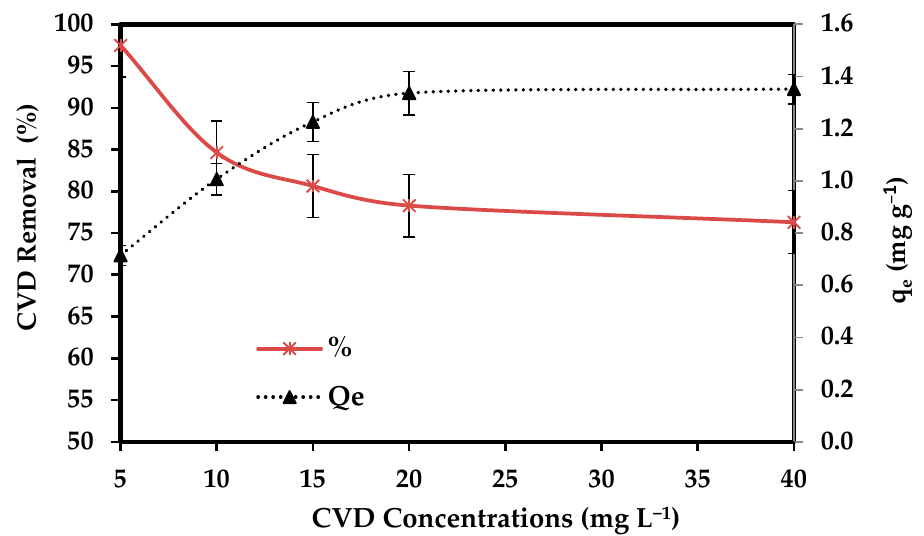
Figure 7. Impact of CVD concentrations on the adsorption process.